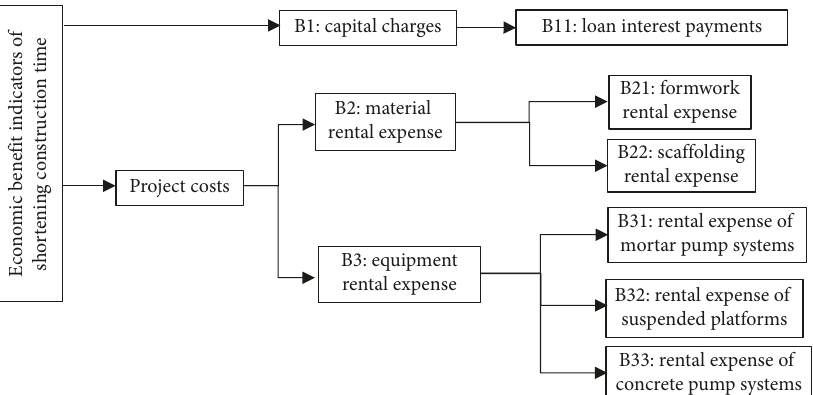
Figure 2: Economic benefits of shortening construction time in prefabricated construction.